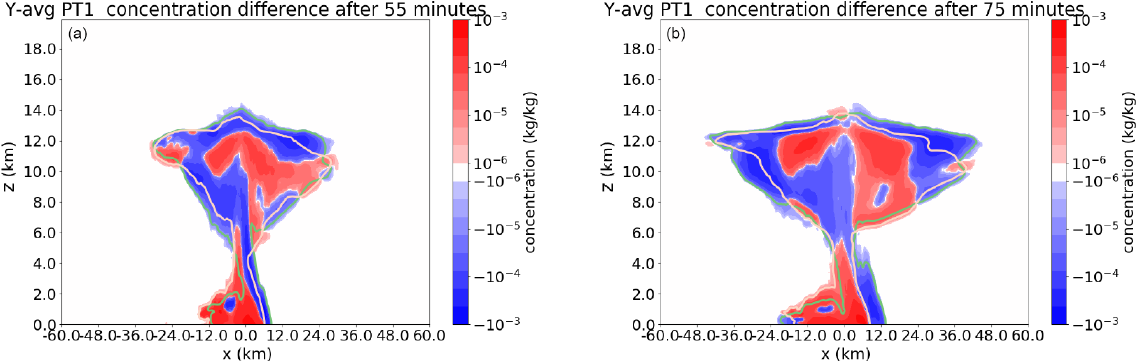
Figure 5. Difference in PT1 concentration between ENS-03 (blue: higher) and reference (red: higher) after 55min (a) and 75min (b) in colours. In addition, the q PT2 = 1 × 10 − 5 kgkg − 1 isoline is shown for both simulations (salmon/bright pink colour: reference; green: ENS-03). The Y average is now taken over the limited sub-space, consisting of 40km > y > − 20km.